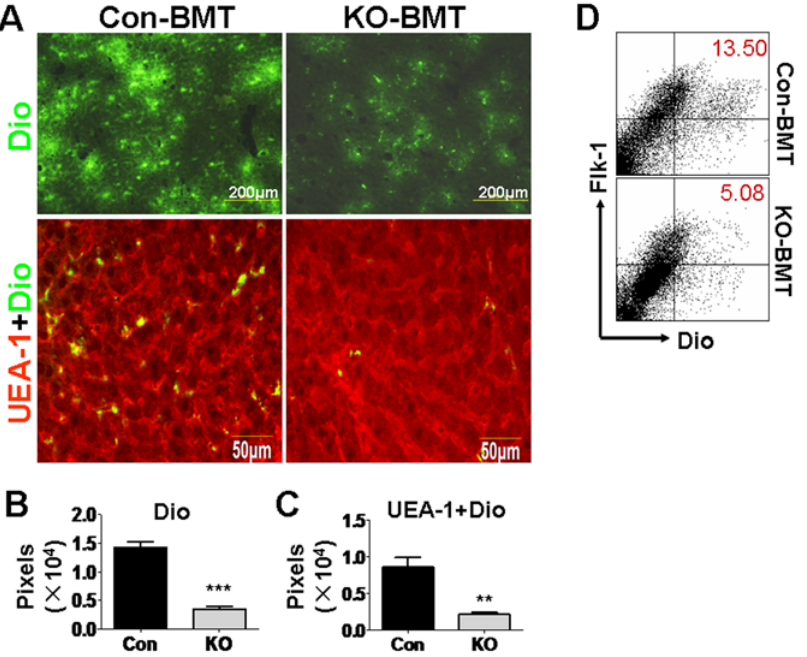
Figure 2. Lowered recruitment of the RBP-J -deleted EPC into the regenerating liver after PHx. Normal mice were subjected to PHx. On the next day of the operation, mice were irradiated, and were transfused with Dio-labeled BM cells from the RBP-J deficient (KO-BMT) or the control (Con-BMT) mice. The recipient mice were analyzed 2 days after the BM transplantation (3 days after PHx). ( A ) The livers of the recipient mice suffering PHx were sectioned, stained for UEA-1, and were examined for Dio + cells (upper) and UEA-1 + Dio + cells (lower). ( B, C ) Dio + cells and UEA-1 + Dio + cells in ( A ) were quantitatively represented by corresponding pixels (bars=mean 6 SD; n=4; ** P , 0.01; *** P , 0.001). ( D ) Livers were perfused with PBS. SECs were purified from the livers of the recipient mice using a kit, and were analyzed for Flk-1 + Dio + cells. The cytograph represented 4 independent experiments with the same results.